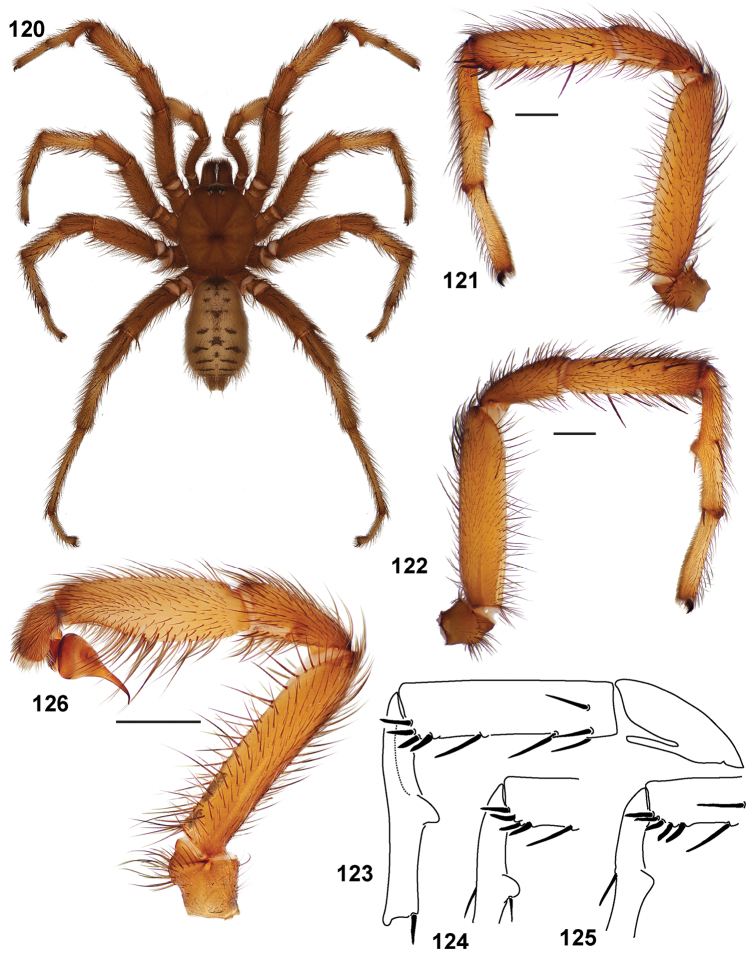
Aptostichus pennjillettei sp. n. from Nevada, Clark Co., Mercury, Nuclear Test Site; scale bars = 1.0mm. 120 habitus, male holotype (AP413) [805830] 121–122 male paratype (AP412), leg I 121 retrolateral aspect [805838] 122 prolateral aspect [805834] 123–125 line drawings of spination patterns on leg I, retrolateral aspect, tibia and metatarsus 126 retrolateral aspect, holotype pedipalp [805832].